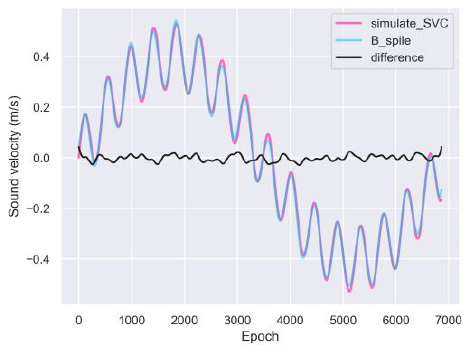
Figure 6 . Sound speed setting and estimation.